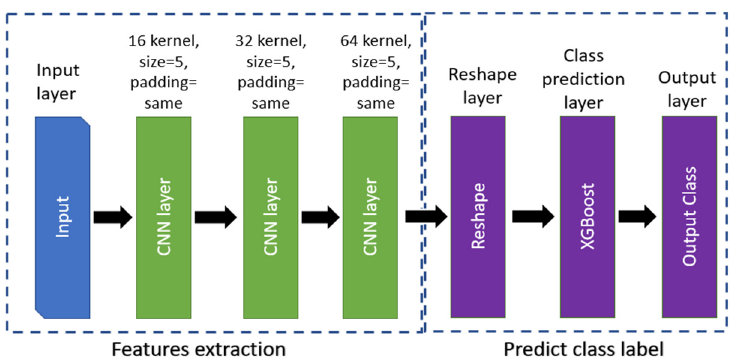
Figure 2. Architecture of the ConvXGB model.